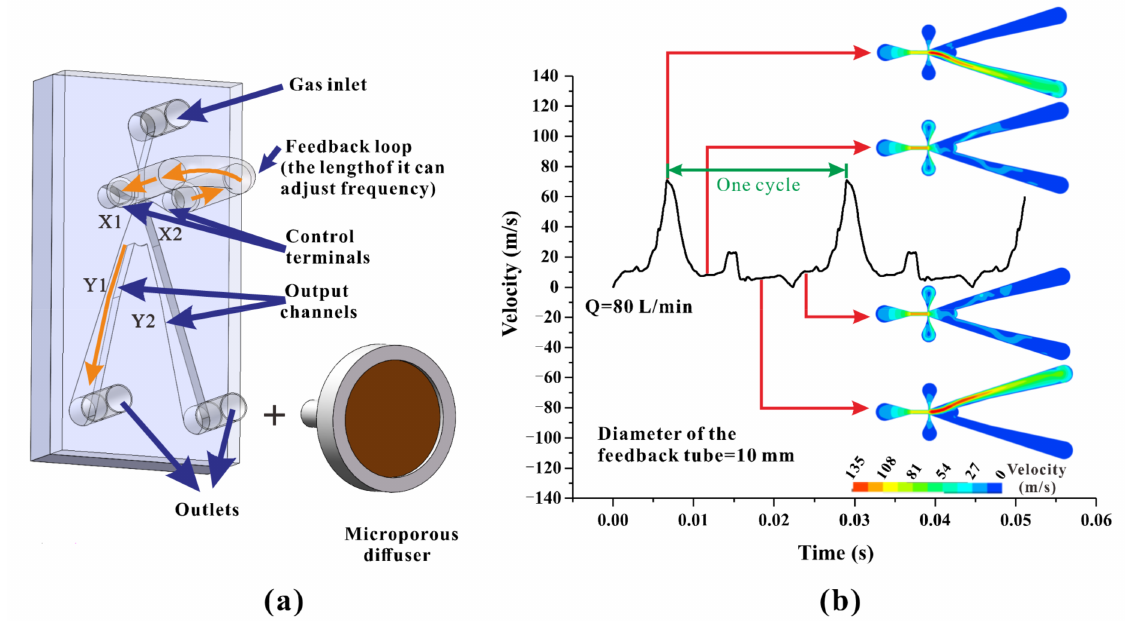
Figure 2. ( a ) Schematic of the microbubble generating device composed of fluidic oscillator and microporous diffuser, ( b ) simulated velocity at one outlet of a fluidic oscillator and the corresponding air switching